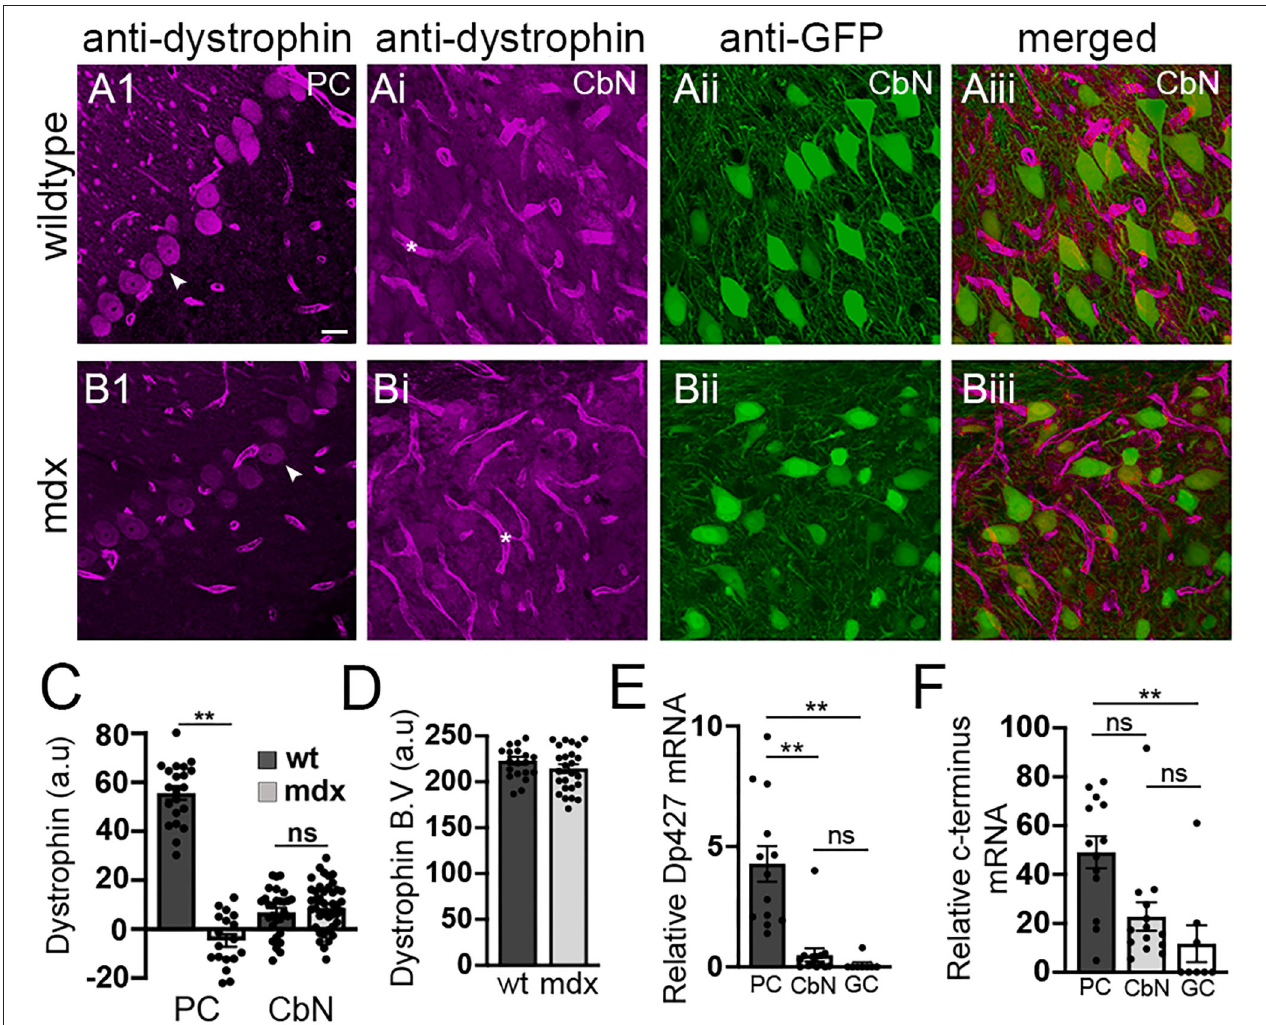
FIGURE 5 | Dystrophin Dp427 isoform is not expressed in glutamatergic projection neurons of the CbN. (A,B) Representative 40x confocal sagittal cerebellar slice images of PC layer (A1,B1) and CbN (Ai,Bi–Aiii,Biii) from wild-type (A) and mdx mice (B) immunolabelled for dystrophin (magenta channel) and GFP (green channel, indicating glutamatergic projection neurons in CbN). (Aiii,Biii) are composite images of dystrophin (Ai,Bi) and GFP (Aii,Bii) labeling in the CbN. Arrowheads indicate PC somata (A1,B1) . Asterix (*) indicates blood vessels (Ai,Bi) . Scale bar: 20 µ m. (C) Summary graph of mean intensity of dystrophin labeling (background subtracted) of PCs and YFP + CbN neurons in wild-type [dark gray bars, n = 21 (PC) and 30 (CbN) cells from 2 animals] and mdx [light gray bars, n = 18 (PC) and 41 (CbN) cells from 2 animals]. (D) Graph of normalized mean intensity of dystrophin labeling of blood vessels in the CbN from wild-type (dark gray bars, n = 21 BV from 2 animals) and mdx (light gray bars, n = 25 BV from 2 animals) mice. (E,F) Summary graphs of mean mRNA expression (normalized to actin) of the Dp247 dystrophin isoform (measured using primers targeted to the N-teminus of dystrophin); (E) , and all dystrophin isoforms (measured using primers targeted to the C-teminus of dystrophin); (F) in PCs (dark gray bars, n = 13 cells from 2 animals), YFP + CbN neurons (Cbn, light gray bars, n = 14 cells from 2 animals) and cerebellar granule cells (GC, white bars, n = 8 cells from 2 animals) using single cell patch qRT-PCR. Error bars indicate SEM. ** p ≤ 0.01. ns, not